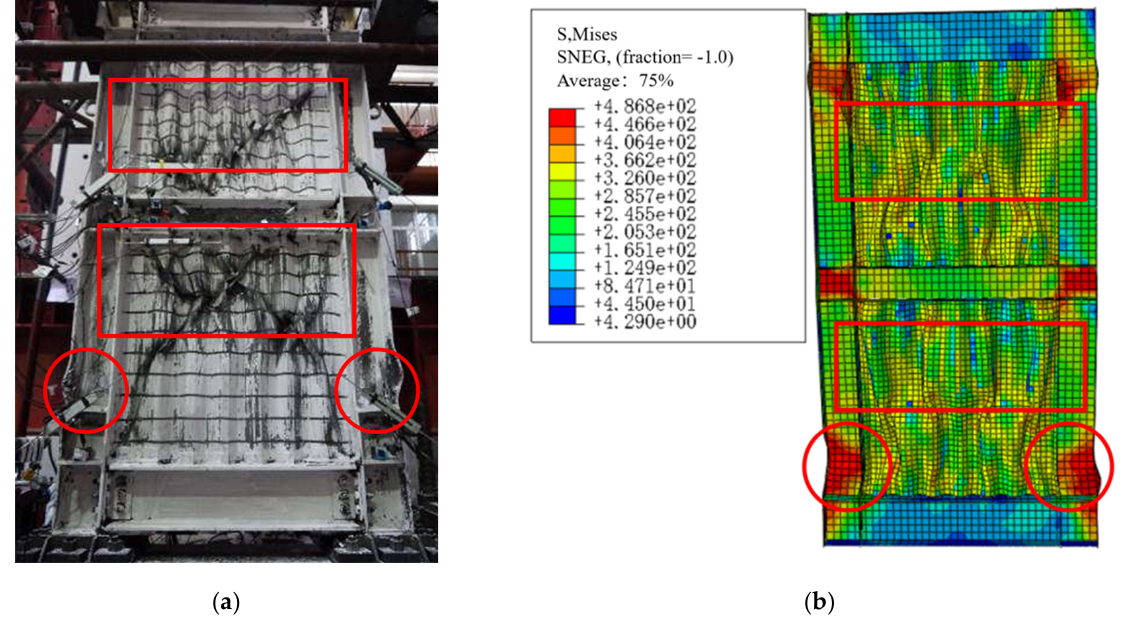
Figure 8. Comparison of the invalidation phenomenon: ( a ) Test phenomenon; ( b ) FEM result.